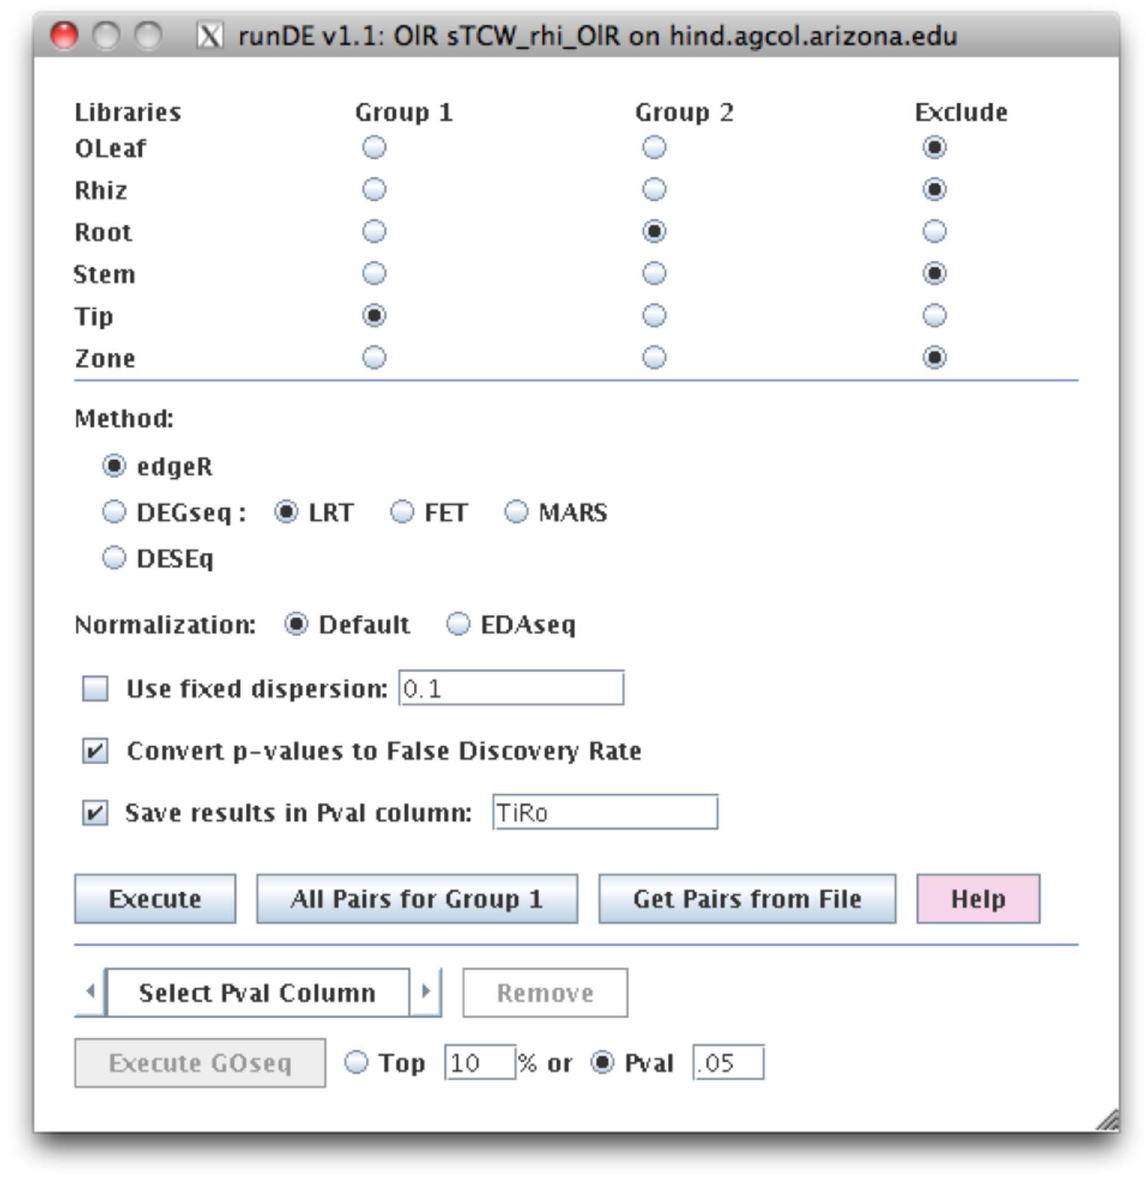
Figure 2. The runDE interface. This shows the setup to compute the differential expression (DE) between tip and root using the edgeR method with default normalization. The results will be written into a database column called ‘‘TiRo’’. Once all DE values are computed, the ‘‘All Pval Columns’’ can be selected followed by ‘‘Execute GOSeq’’ to compute the corresponding GO differential expression p-values.